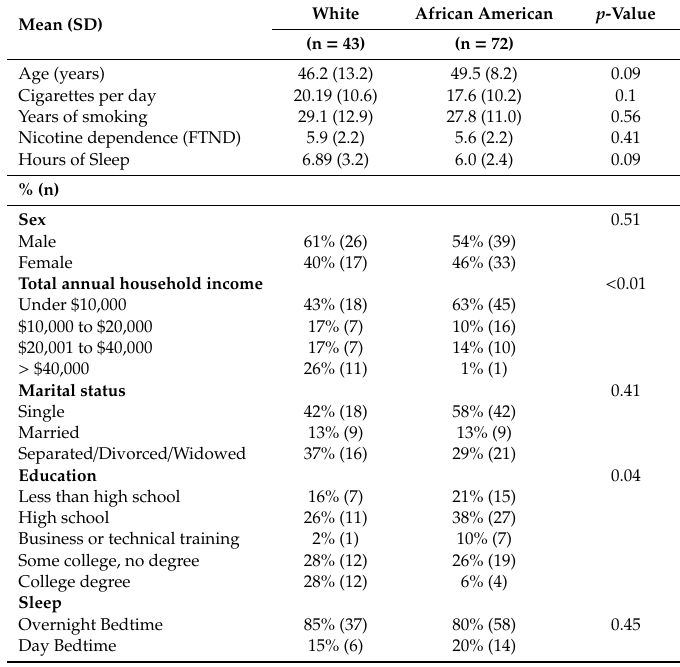
Table 1. Demographic Characteristics by Racial / Ethnic